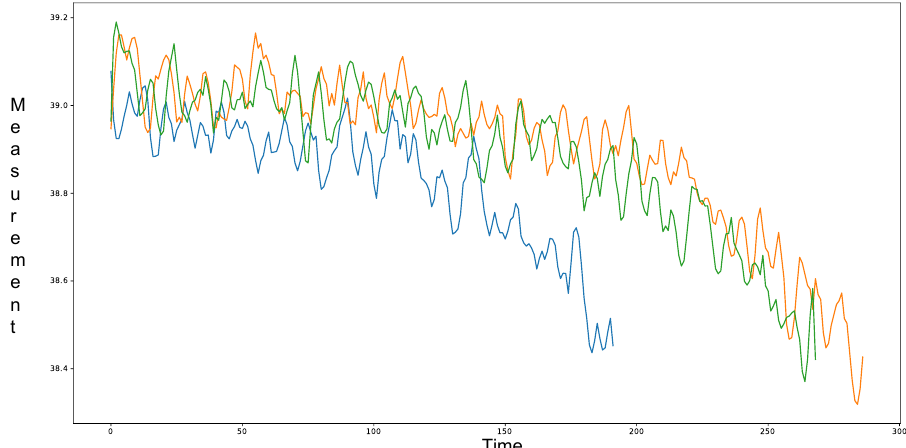
Figure 4. Example of data of operation of energy equipment [18] with values of three arbitrary sensors over